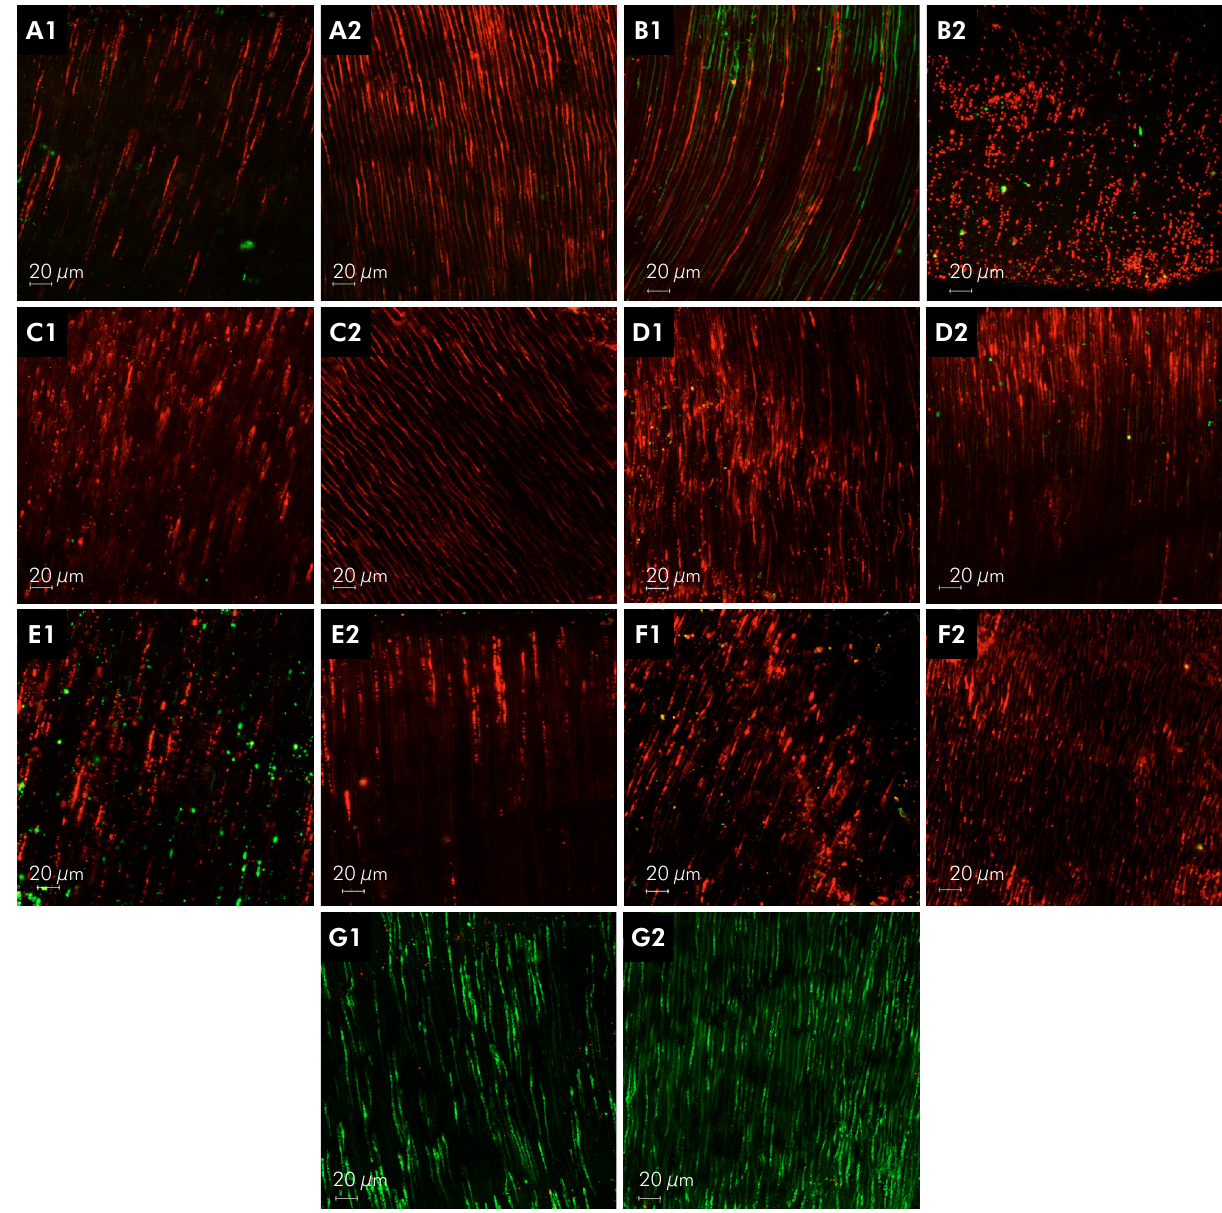
Figure. CLSM images of specimens treated with (A) NaOCl + EDTA followed by PUI; (B) a mixture of NaOCl/HEBP followed by PUI; and (C) NaOCl + EDTA-T followed by PUI. (D), (E), and (F) were subjected to the same irrigation protocols as the above groups but were treated with the XP-Endo Finisher instrument. (G) Control group. Number 1 corresponds to the cervical third; number 2 is the medium third. Viable bacteria are indicated in green, and nonviable bacteria are indicated in red. Magnification: 40 x. Bars: 20.0 μ